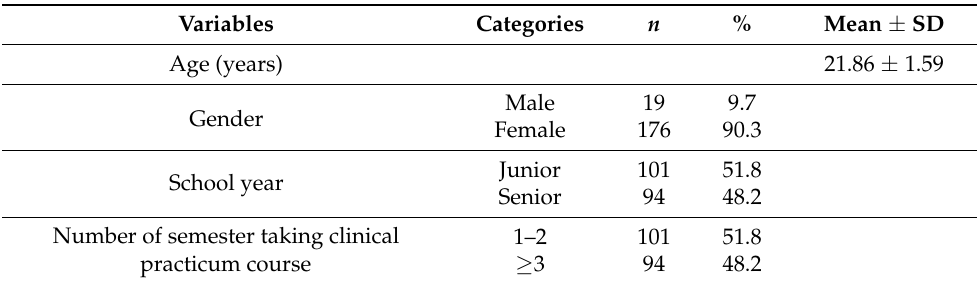
Table 1. General characteristics ( n = 195).